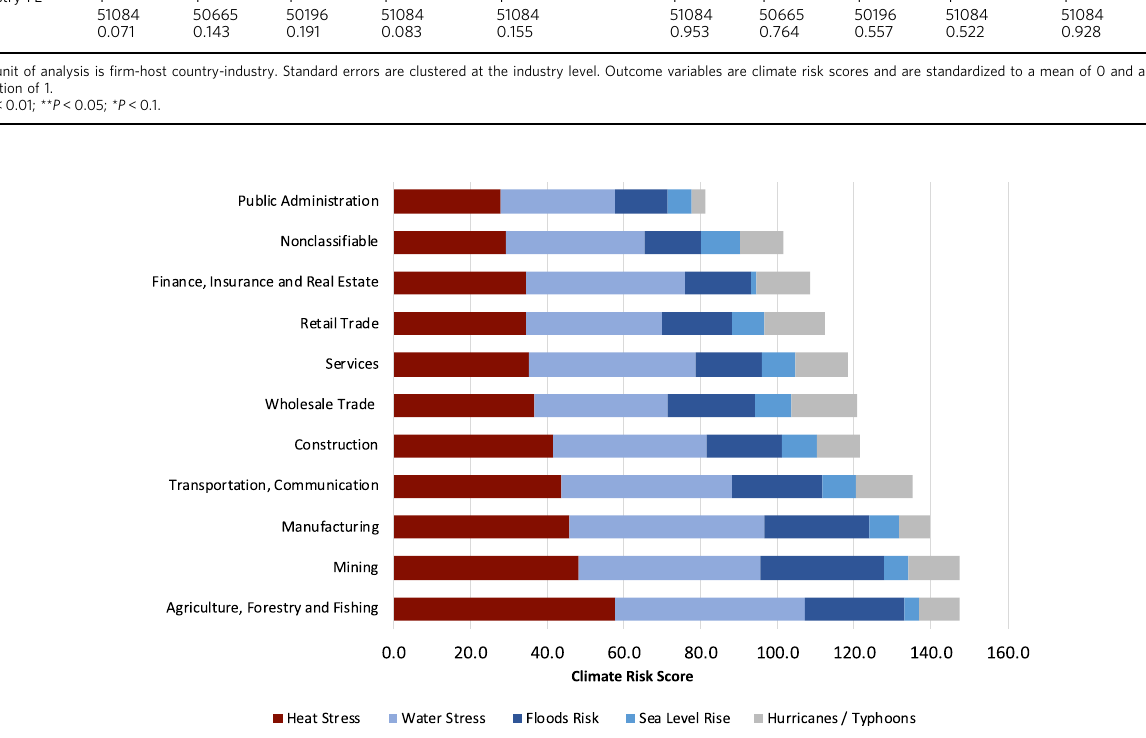
Fig. 2 Average climate risk scores of overseas facilities by industry. Analysis is based on climate risk scores and facility statistics of 2233 public companies from Four Twenty Seven. Transportation and Communication sector includes transportation, communications, electric, gas and sanitary service.